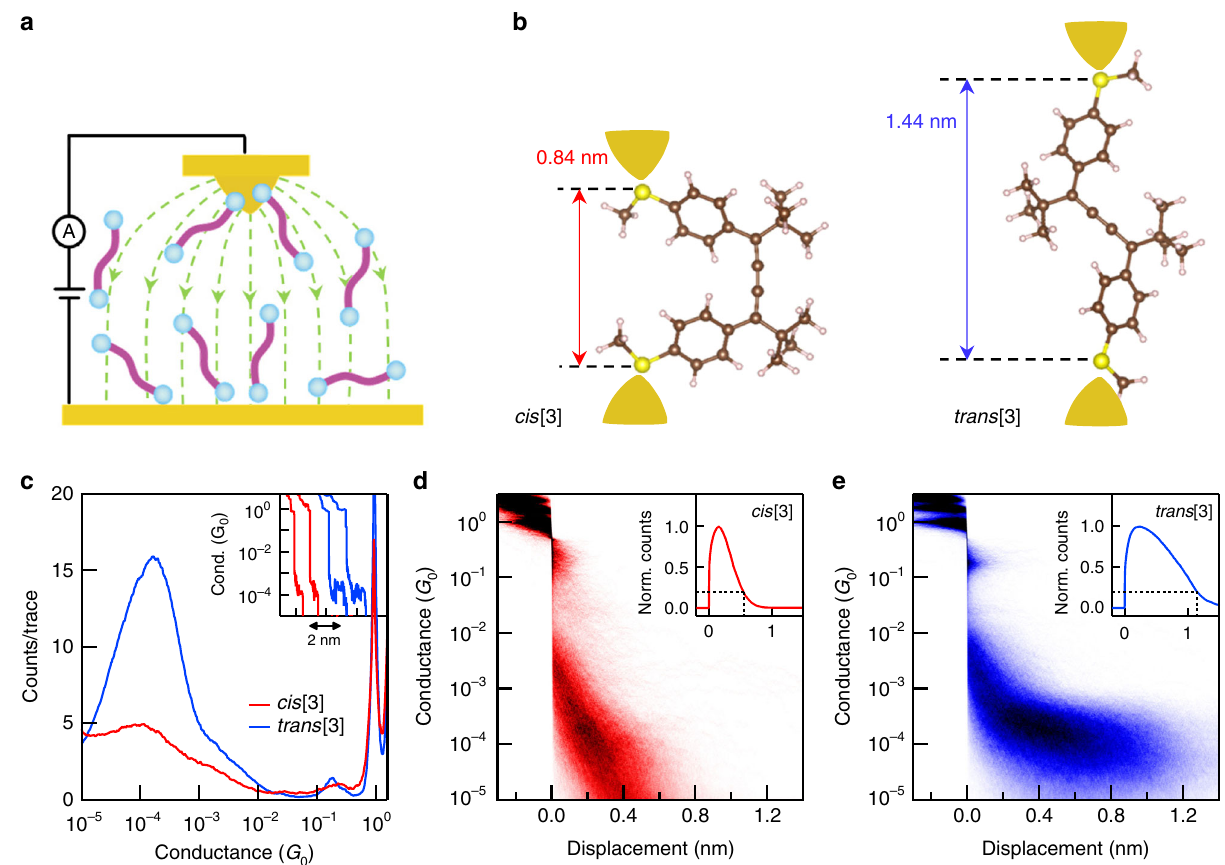
Fig. 1 Conductance measurements of cumulene isomers in solution. a Schematic of the STM setup and the electric fi eld distribution between the STM tip and substrate (green line). b Illustration of the single-molecule junctions with DFT-optimized structures of cis[3] and trans[3] showing distinct S – S distance. The electrodes are model structures not included in the calculations. c Logarithm-binned 1D histograms for cis[3] (red) and trans[3] (blue) measured in tetradecane at a 0.1 V bias created by compiling 5000 and 9000 conductance traces, respectively. Inset: example conductance vs. displacement traces of cis[3] (red) and trans[3] (blue). d , e 2D conductance-displacement histograms for cis[3] and trans[3] , respectively, created by overlaying conductance traces after aligning them at a conductance of 0.5 G 0 . Inset of d and e : normalized displacement pro fi les of cis[3] (red) and trans [3] (blue), respectively, determined from the 2D histograms. The 80th percentile junction length is 0.55 nm for cis[3] and 1.15 nm for trans[3] as indicated by the dashed